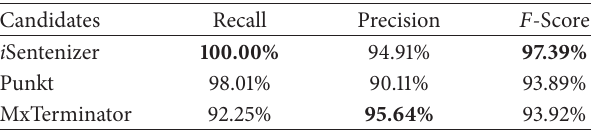
Table 13: Results of cross Europarl corpora evaluation.